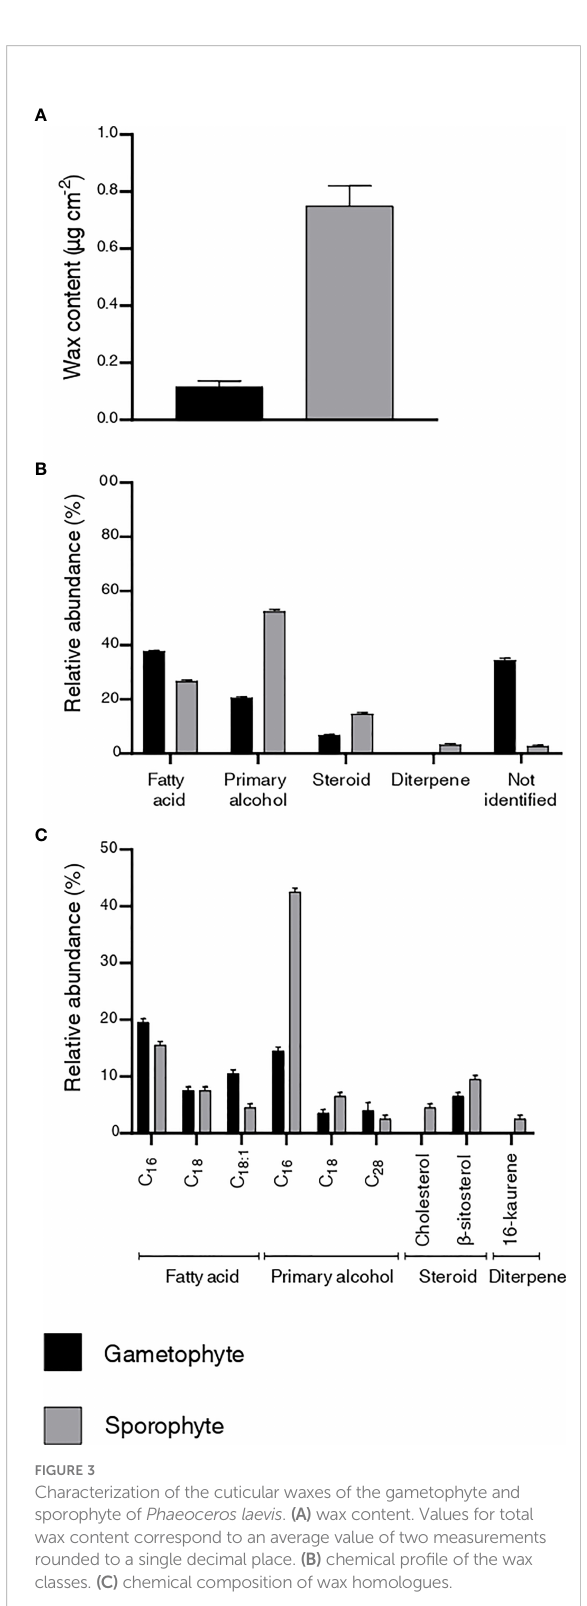
FIGURE 3 Characterization of the cuticular waxes of the gametophyte and sporophyte of Phaeoceros laevis . (A) wax content. Values for total wax content correspond to an average value of two measurements rounded to a single decimal place. (B) chemical pro fi le of the wax classes. (C) chemical composition of wax